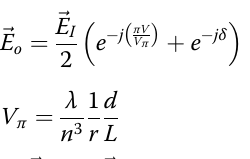
causes phase change π of phase shifter. And λ is the input wavelength, n is the corresponding refractive index, r is electro optic coef fi cient, L is the length of interferometric arms and d is the thickness of PCM. Combining the expressions above, the mathematical form of nonlinear activation function achieved by nonlinear accelerator can be written explicitly as